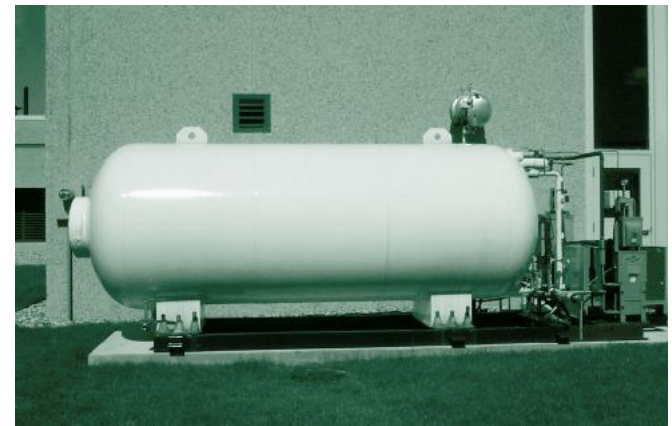
Figure 22. PCC fiber loading system (Forest products, NICE 3 project